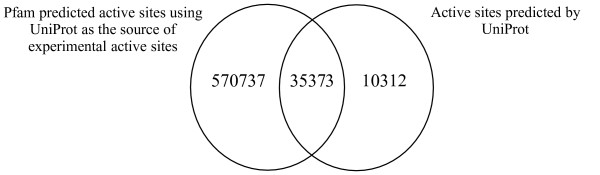
A Venn diagram comparing the active sites predicted by our methodology using the UniProtKB experimental active sites (Pfam predicted active sites) with the predicted active site residue annotation in UniProtKB.